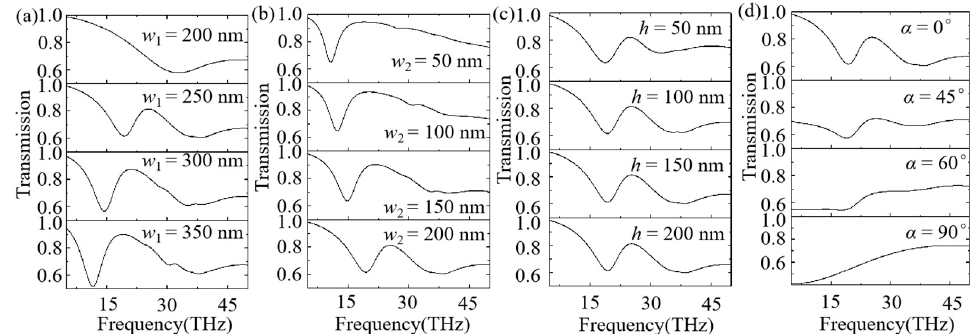
Figure 3. ( a ) Transmission spectra as a function of w 1 with w 2 = 200 nm, h = 150 nm, and α = 0°. ( b ) Transmission spectra as a function of w 2 with w 1 = 250 nm, h = 150 nm, and α = 0°. ( c ) Transmission spectra as a function of h with w 1 = 250 nm, w 2 = 200 nm, and α = 0°. ( d ) Transmission spectra as a function of the polarization direction of incident light α with w 1 = 250 nm, w 2 = 200 nm, and h = 150 nm.